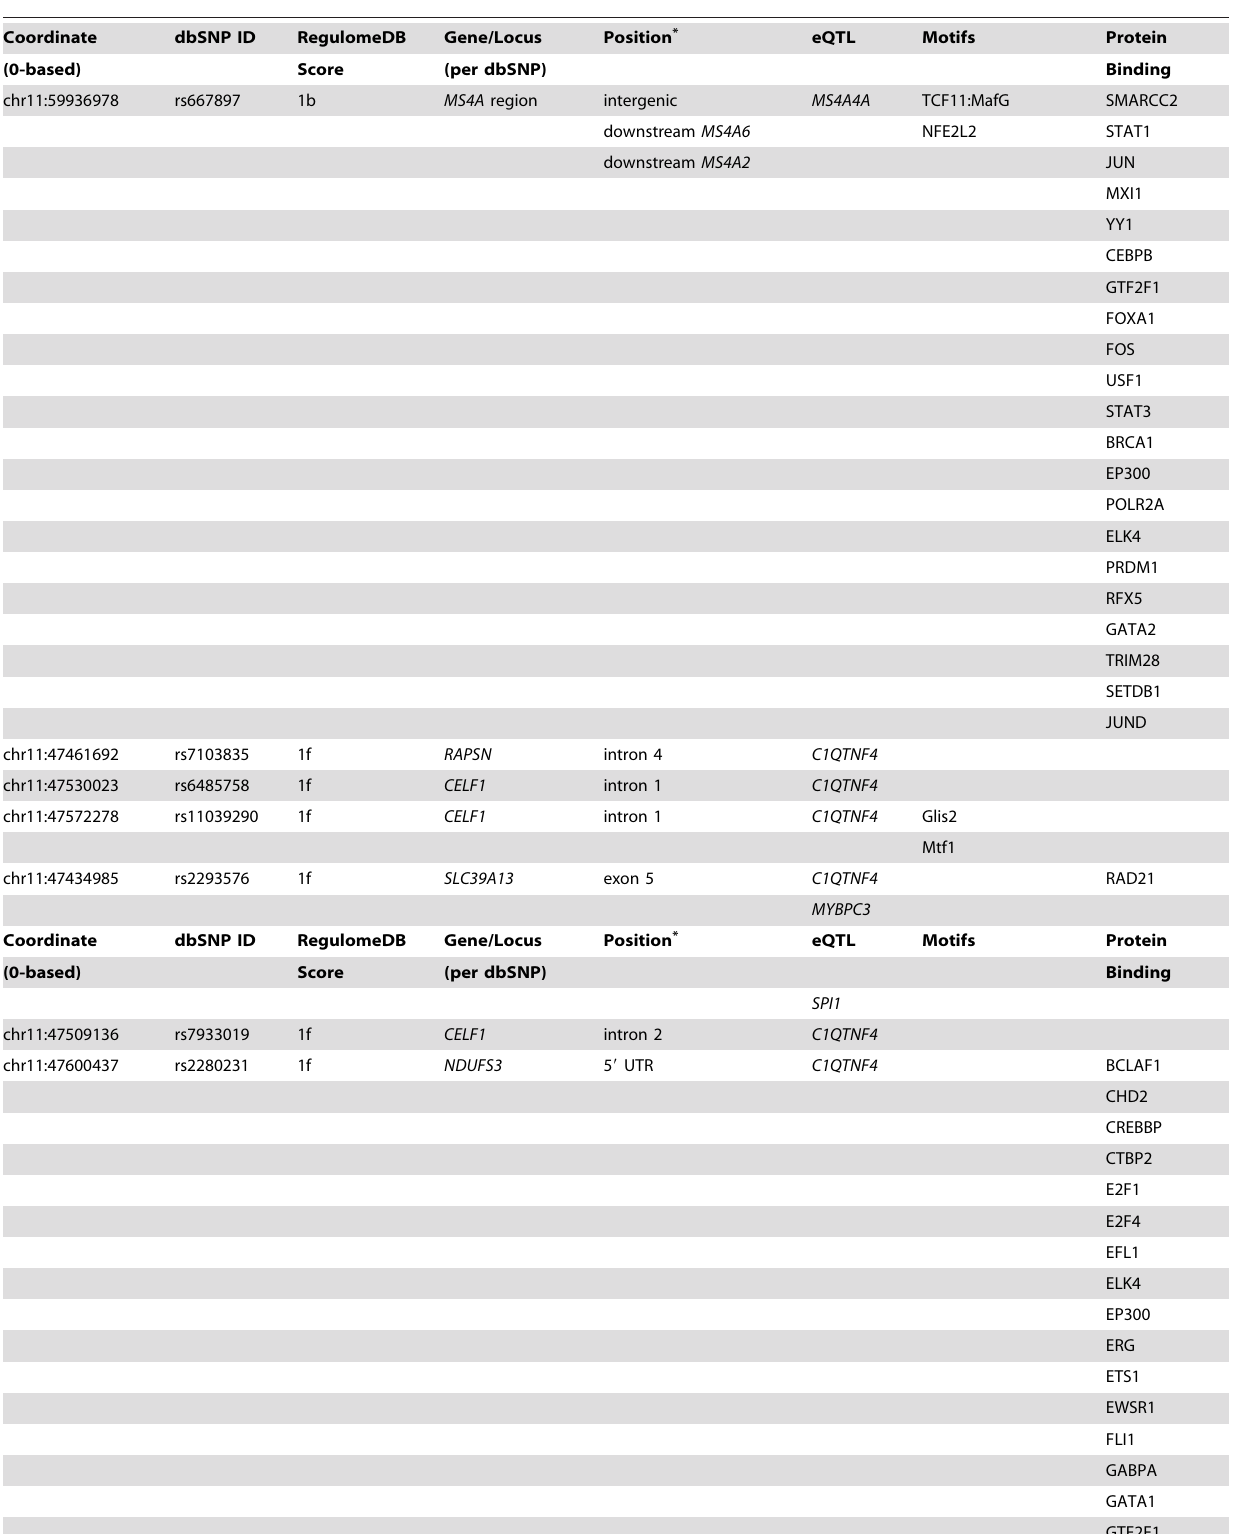
Table 3. Details of study SNPS with putative regulatory function (RegulomeDB Score , 3).